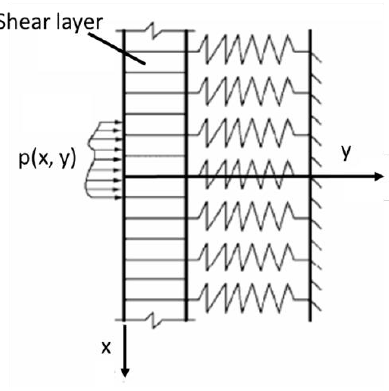
Figure 1. Pasternak foundation model.